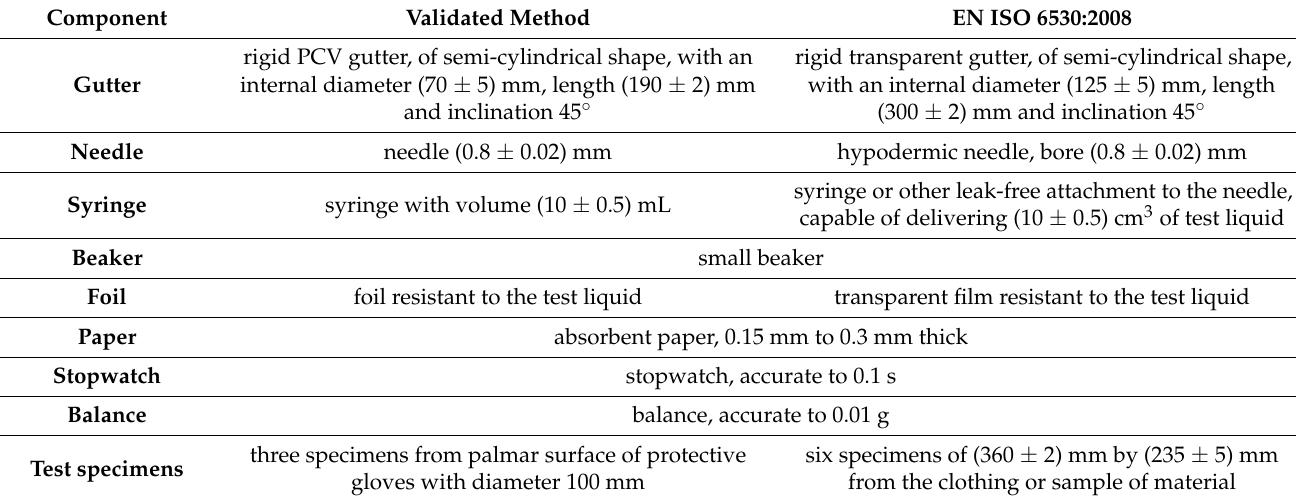
Table 2. Comparison of the components of validated method and method according to EN ISO 6530:2008 [31].